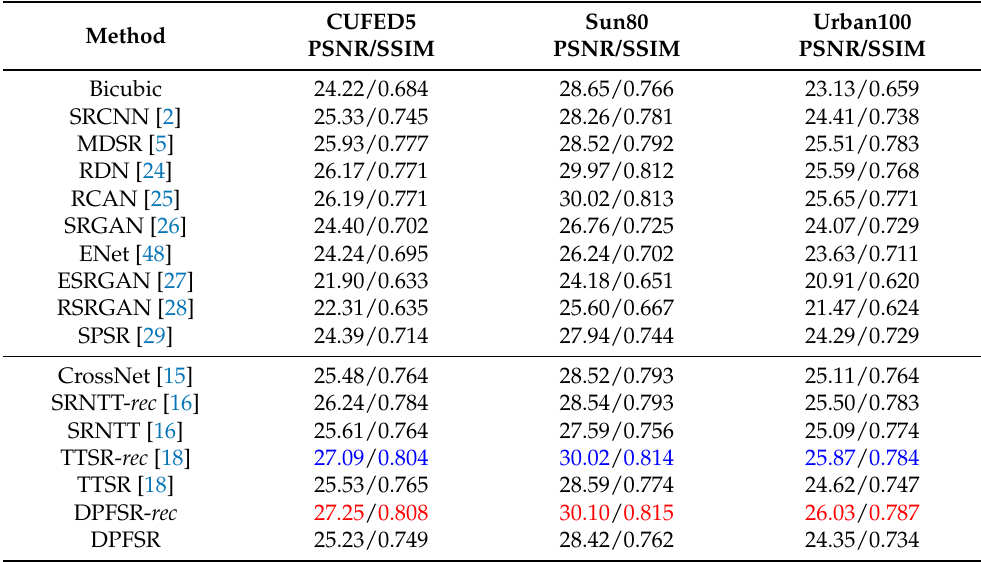
Table 5. Quantitative comparison with other SR methods on three benchmark datasets. We group methods by SISR (top) and RefSR (bottom). The best performance is highlighted in red, while the second-best performance is highlighted in